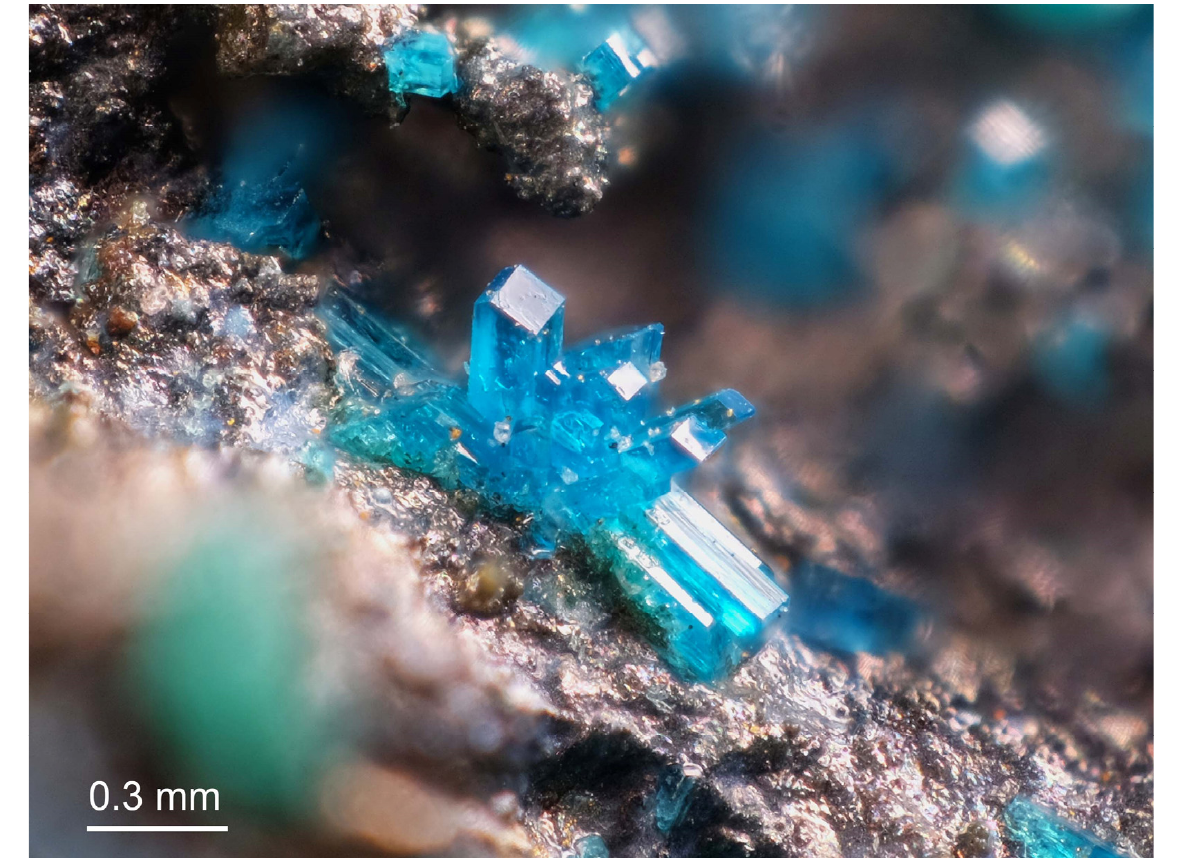
Figure 11. Optical image showing light blue monoclinic langite crystals from the Mastricarro Barite Mine (Catanzaro, southern Italy) arranged in a radial pattern.